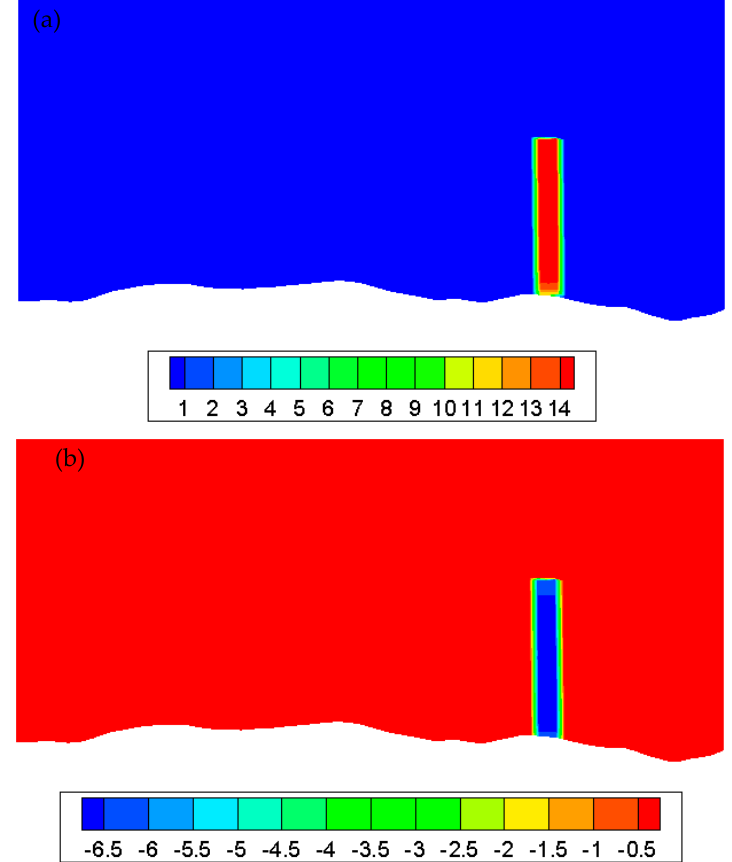
Figure 11. Interpolated velocity (m/s) in the vicinity of Mast-01: ( a ) u component (m/s); ( b ) v component (m/s). The horizontal radius and vertical radius influenced by the WRF grid points are set as 100 m and 50 m, respectively. The height of WRF profile chosen to be interpolated is 1200 m.